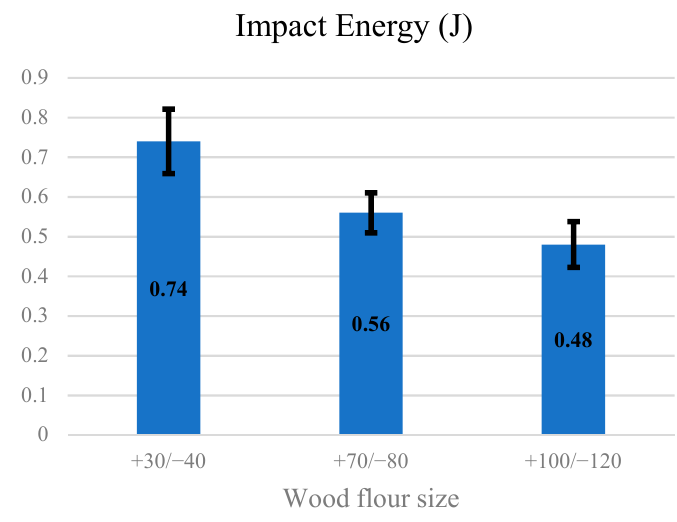
Figure 5. Effect of wood powder size on impact energy.